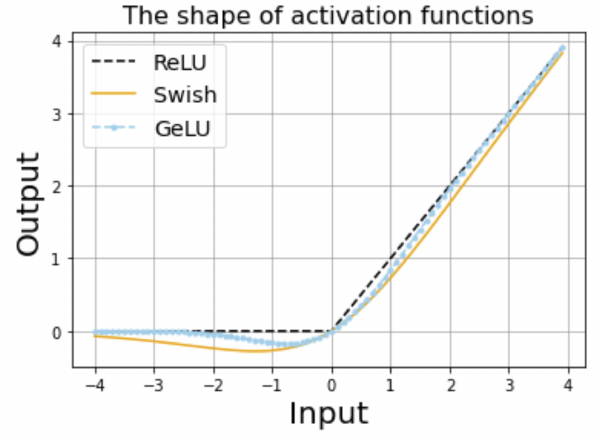
Figure 13. Comparison of GeLU, ReLU, and